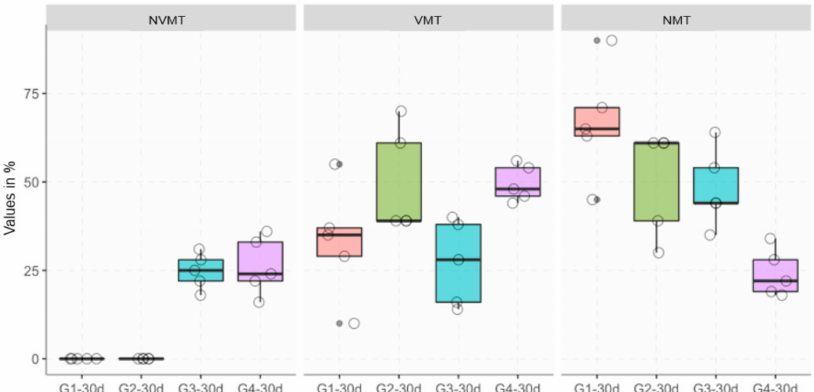
Figure 8. Boxplot of histomorphometric data across the 30-day